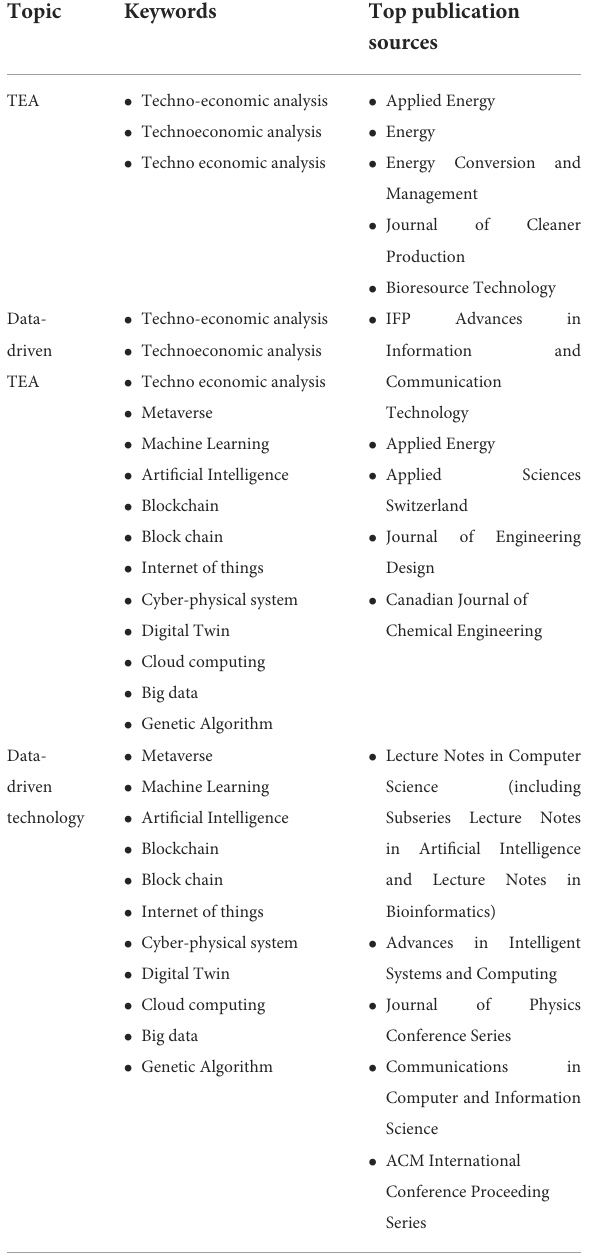
TABLE 2 Bibliometric trends related to TEA, data-driven TEA, and data-driven